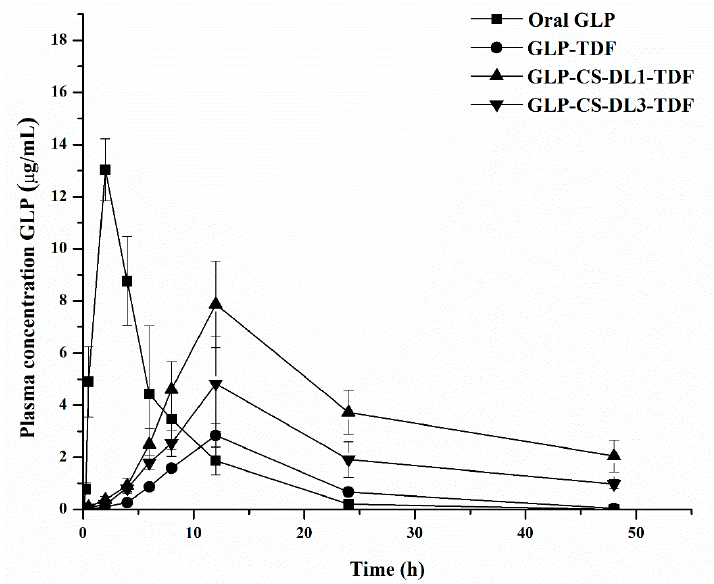
Figure 6. Plasma concentration–time profile of GLP after oral and transdermal film treatment in rats. The results are the mean ± SD, n = 5. Table 6. Pharmacokinetic parameters of GLP after oral and transdermal administration in rats ( n = 5, mean ±